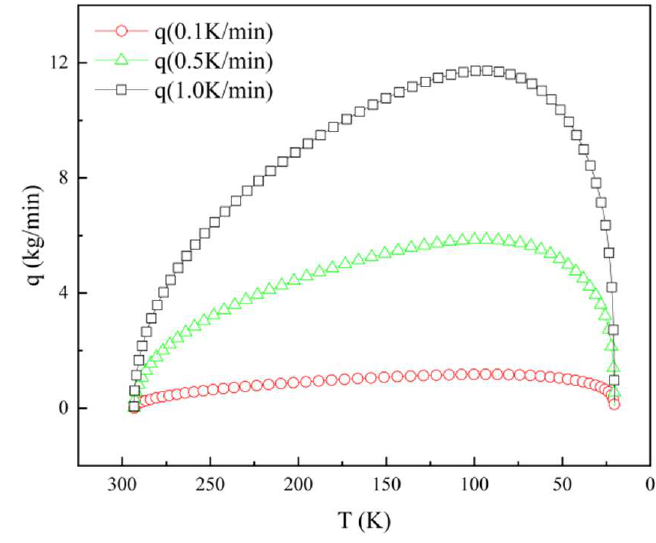
Figure 7. Total liquid hydrogen flows at different cooling rates.